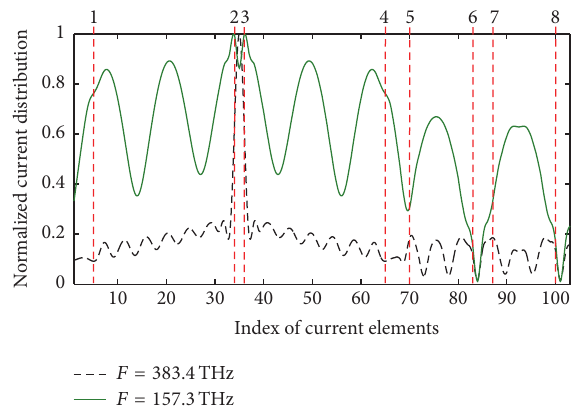
Figure 19: Current distribution in the nanocircuit for 𝐹 = 157.3 and 383.4 THz, for cases with reflection coefficient |Γ 𝑉 | = − 7.6 and − 13.5 dB,